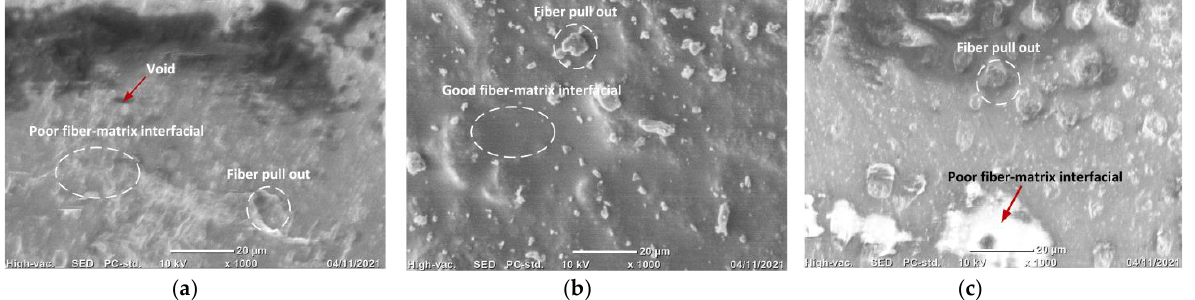
Figure 7. Water absorption test result.